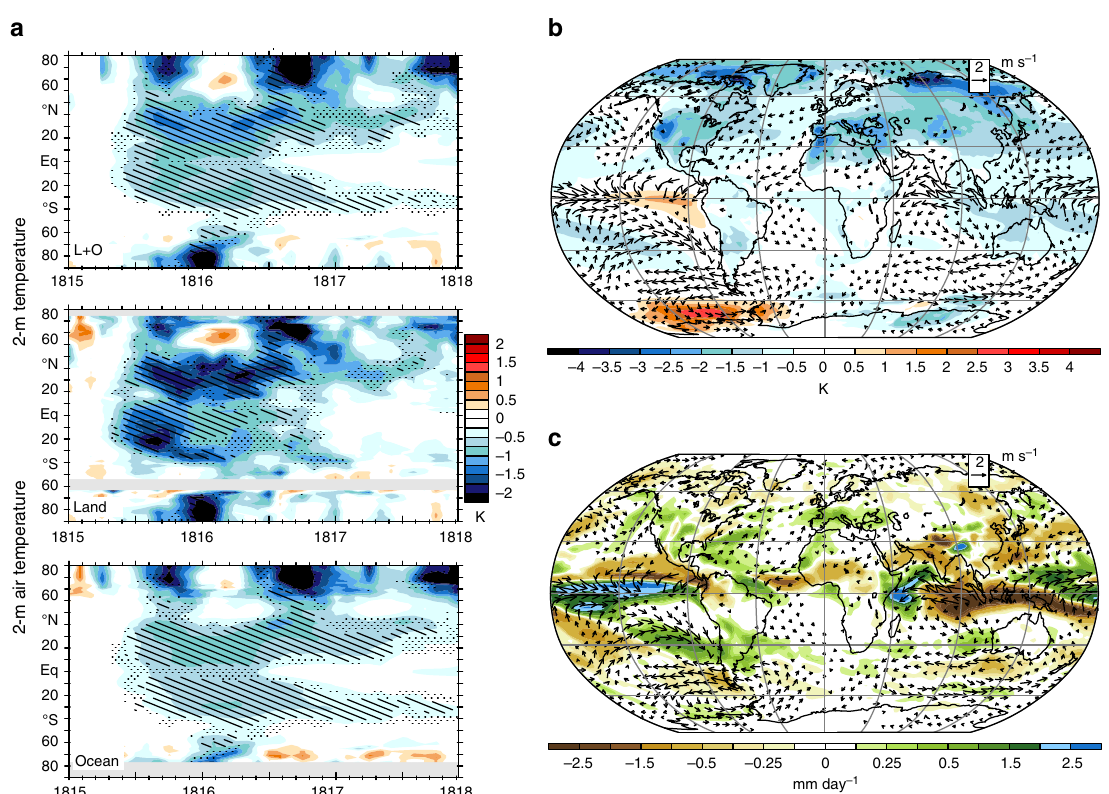
Fig. 4 Regional-simulated responses to the 1815 eruption. a Zonal mean T for land and ocean (L + O), and land, and ocean, separately and YWAS July through September near-surface winds and b T and c P . Mapped colors ( b , c ) and hatching ( a ) indicate anomalies exceeding twice the ensemble standard error. Stippled regions in a indicate anomalies between one and two times the standard error. Years indicated on the abscissas begin at the corresponding tick marks